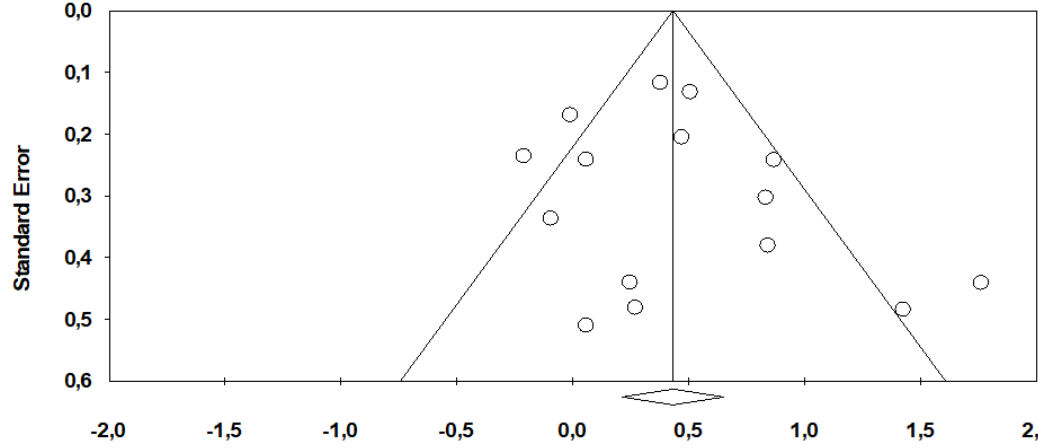
Figure 4. Funnel plots showing log hazard ratios and standard errors for overall survival.